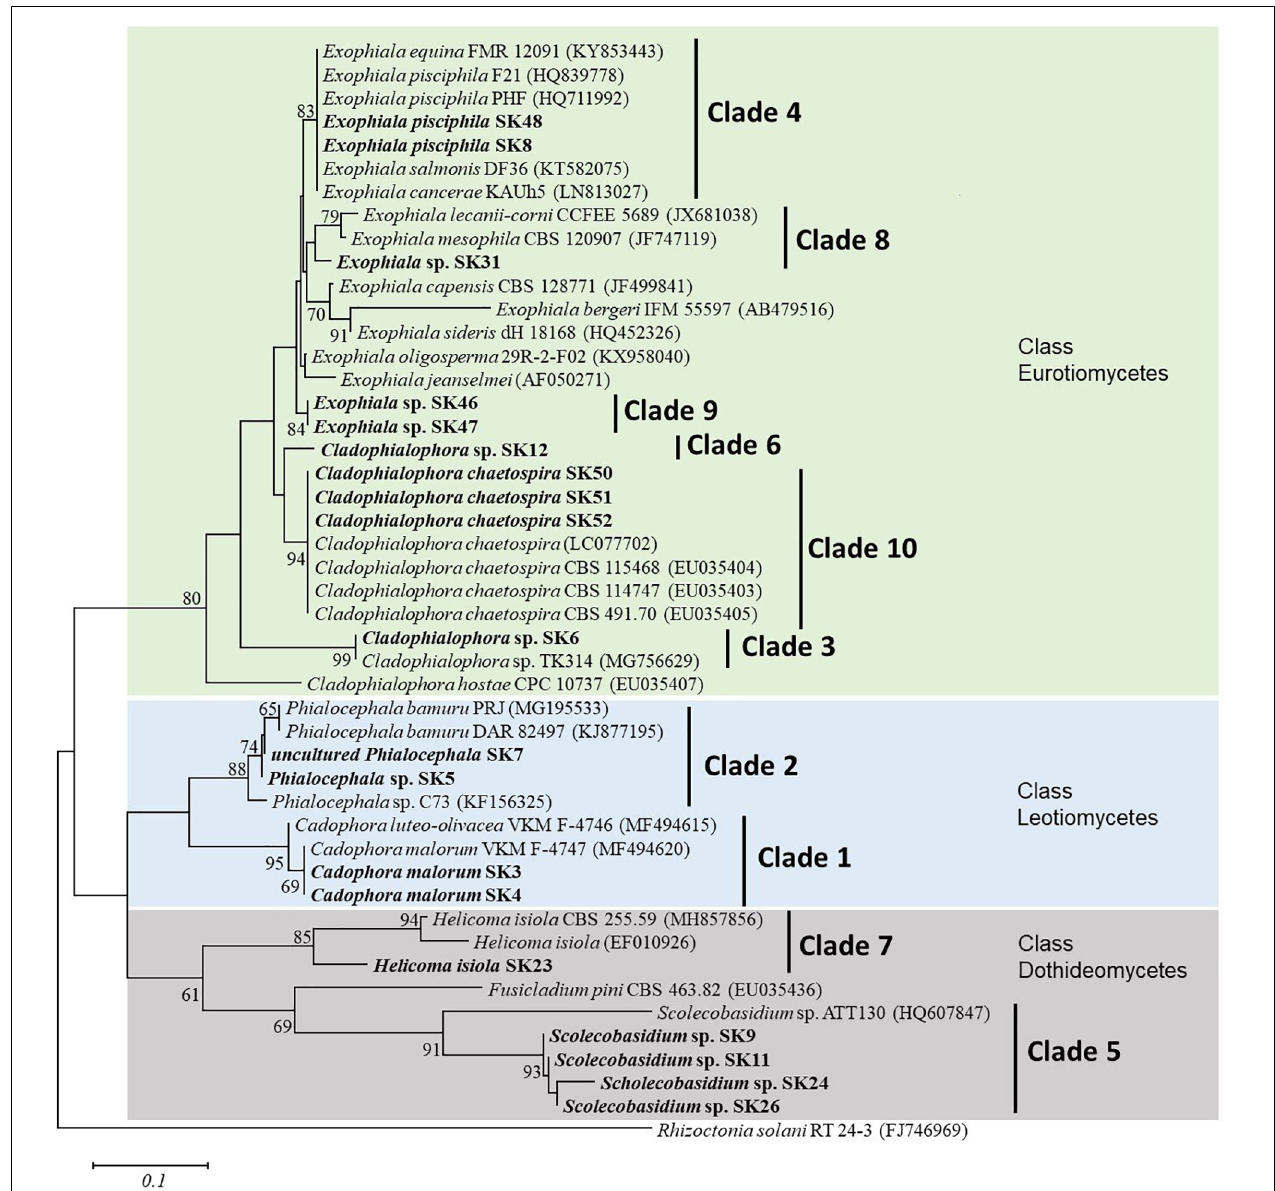
FIGURE 1 | Neighbor-joining phylogenetic tree of nineteen fungal isolates in the present study and reference sequences retrieved from the NCBI GenBank database. This tree was derived from the analysis of three (SSU, ITS, and LSU) sequences. Rhizoctonia solani RT 24-3 (FJ746969) was used as an outgroup. Numbers at the nodes are bootstrap support values (percentage of 1,000 replicates); only values above 60% are displayed. Bar represent 0.1 substitutions per nucleotide position. The fungal isolates from this study are in